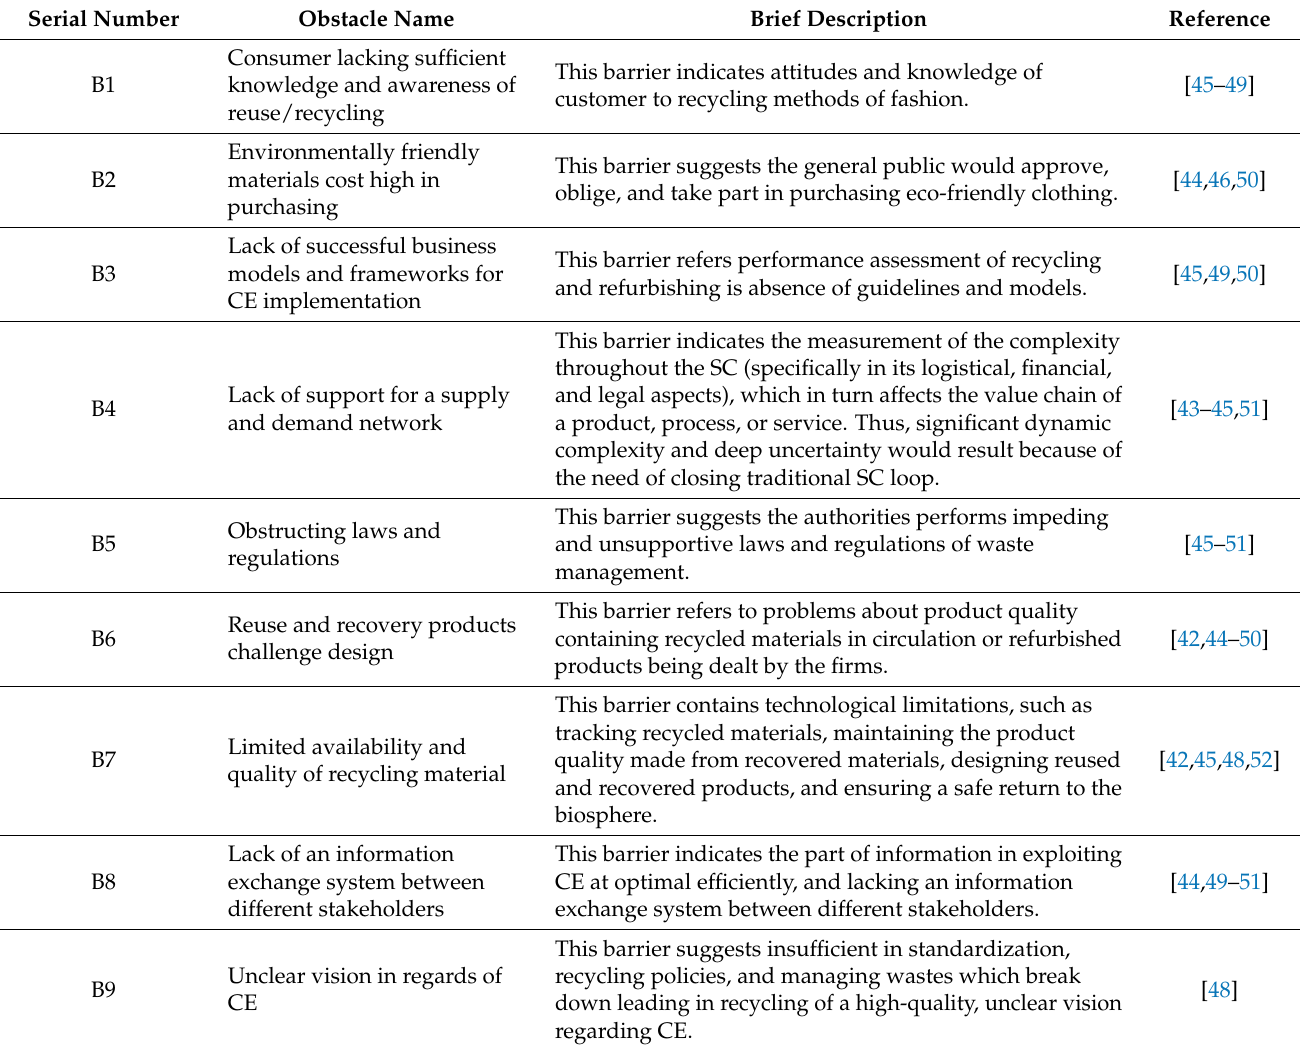
Table 1. The adoption of CE obstacles with